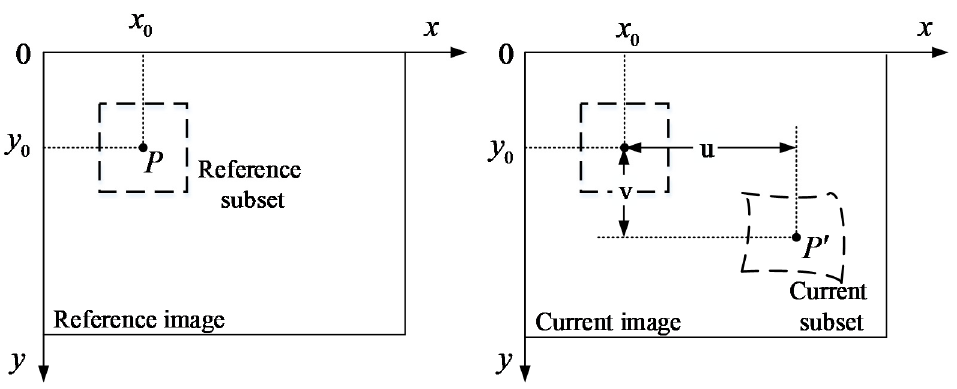
Figure 4. Principle graph of the two-dimensional digital image correlation (2D-DIC) method.